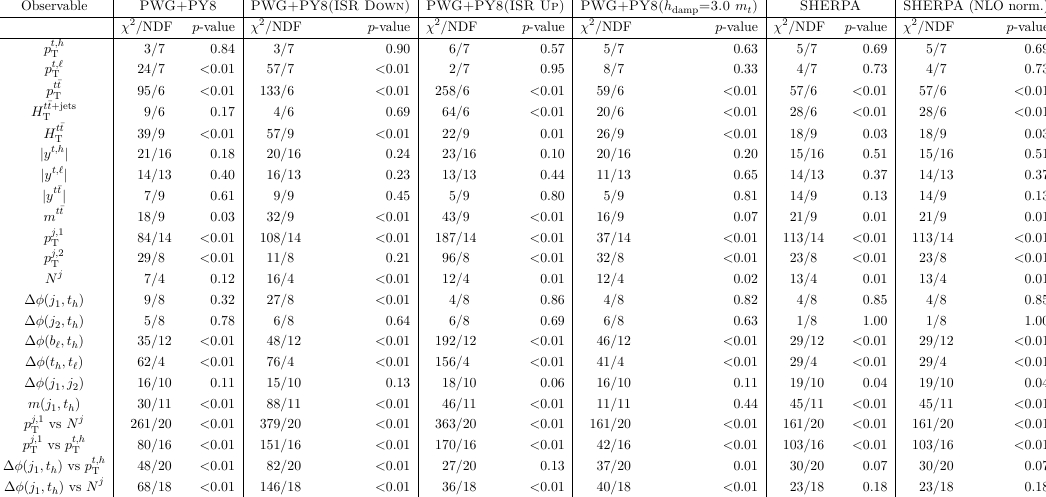
Table 7. χ 2 and p -values quantifying the level of agreement between the relative unfolded spec- tra and several NLO+PS predictions. PWG+PY8 corresponds to the Powheg+Pythia sample. SHERPA (NLO norm.) refers to the Sherpa sample with its default normalisation. All other samples are normalised to the inclusive NNLO+NNLL t ¯ t cross-section prediction.